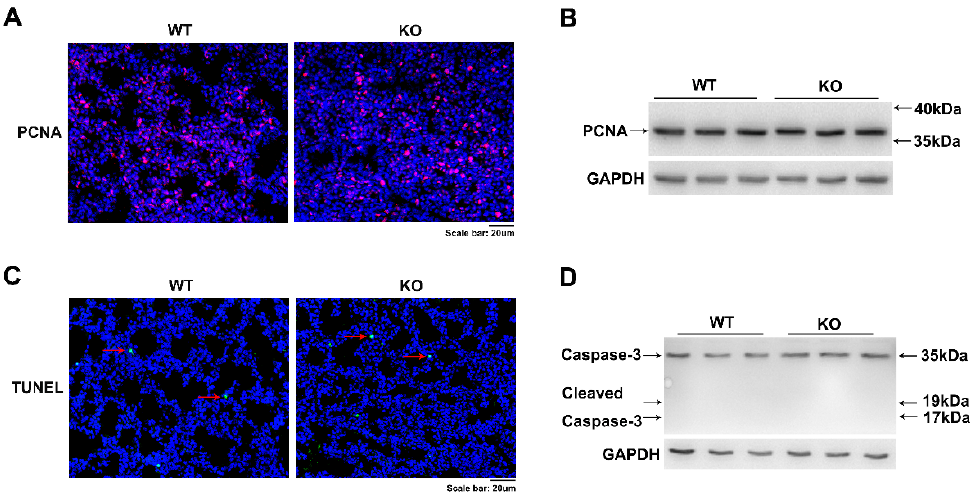
Figure 4. Kub3 deletion has no effect on lung cell proliferation and cell apoptosis. ( A ) Immunostaining of PCNA in lung sections of E18.5 lungs. Nuclei were stained blue with 4’,6-diamidino-2-phe- nylindole (DAPI). Scale bar: 20 µm. ( B ) Western blot analysis of PCNA protein level in E18.5 lungs. GAPDH was used as a loading control. ( C ) Cell apoptosis analysis of cells in E18.5 lungs examined by terminal deoxynucleotidyl transferase dUTP nick end labeling (TUNEL) assay. Arrows indicate TUNEL-positive nuclei. Scale bar: 20 µm. ( D ) Western blot analysis of protein levels of caspase-3 and cleaved caspase-3 in the KO lung at E18.5. GAPDH expression is the protein loading control. 2.5. Kub3 Deletion Impairs the Differentiation of Alveolar Epithelial Cells and the Maturation of AECIIs